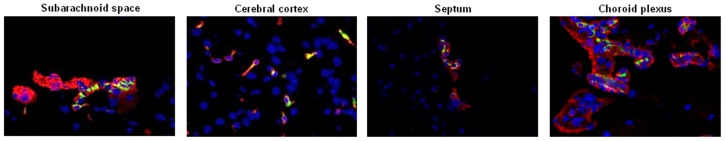
Vasculature in the different compartments of the mouse brain.Immunofluorescent detection of CD31 (488 nm green signal), tomato lectin (594 nm red signal) and nuclei (350 nm blue signal) in the brain of mock infected mice; total magnification 630X. Double staining with anti CD31 antibody and the lectin showed that the tomato lectin provides a more comprehensive detection of the brain vasculature.